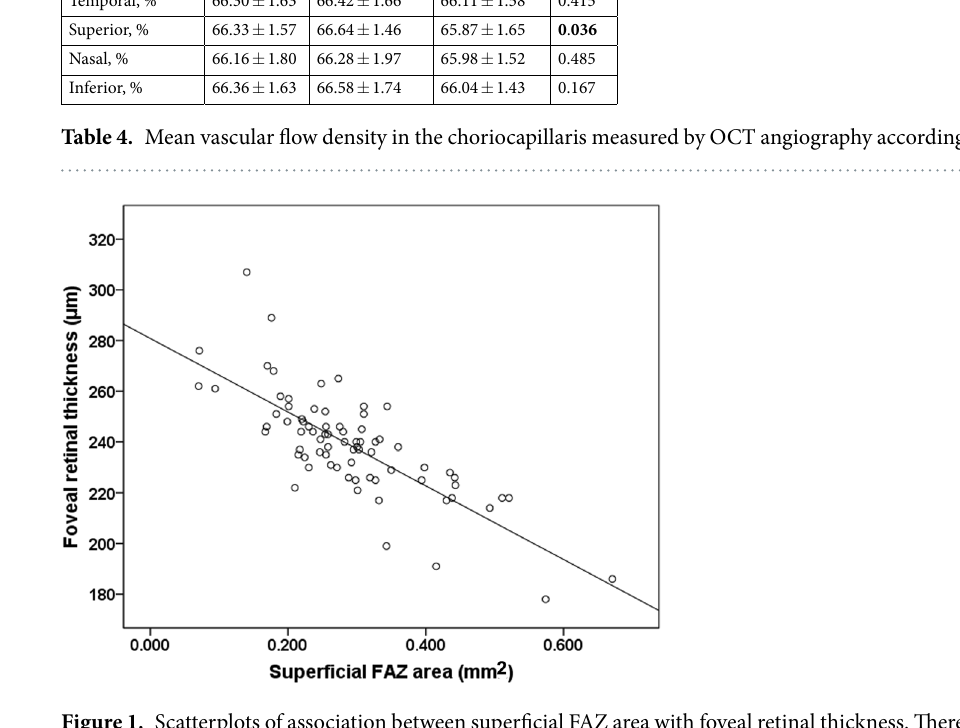
Figure 1. Scatterplots of association between superficial FAZ area with foveal retinal thickness. There is a strong negative correlation between the superficial FAZ area and foveal retinal thickness ( r = − 0.745, P < 0.001; Pearson partial analysis, adjusting for